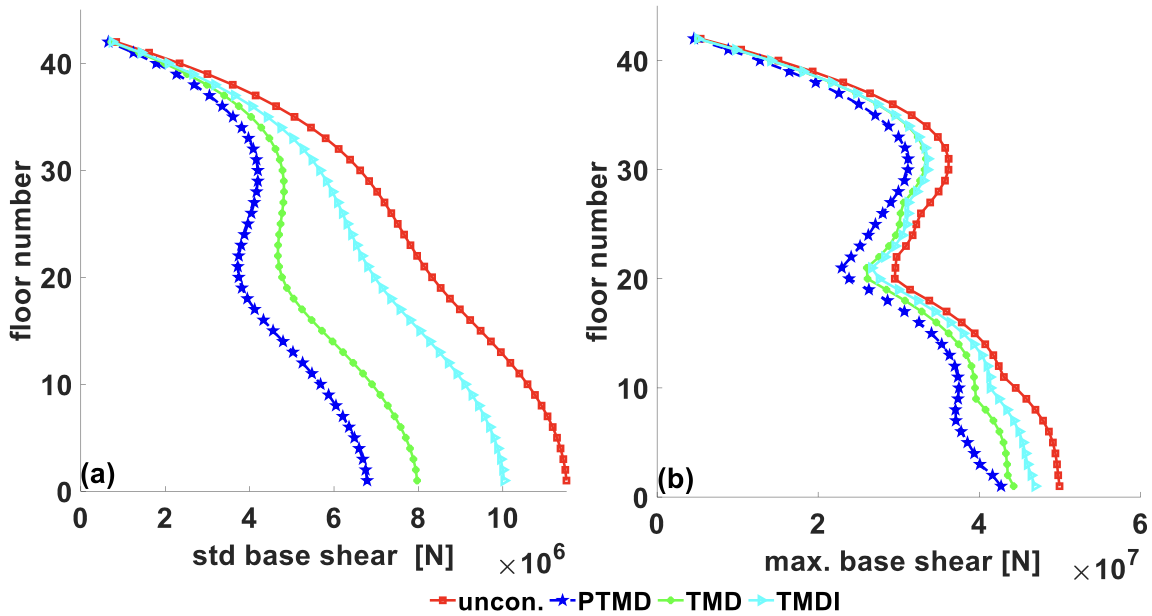
Figure 21. Base shear at each floor: ( a ) STD shear, ( b ) maximum shear.